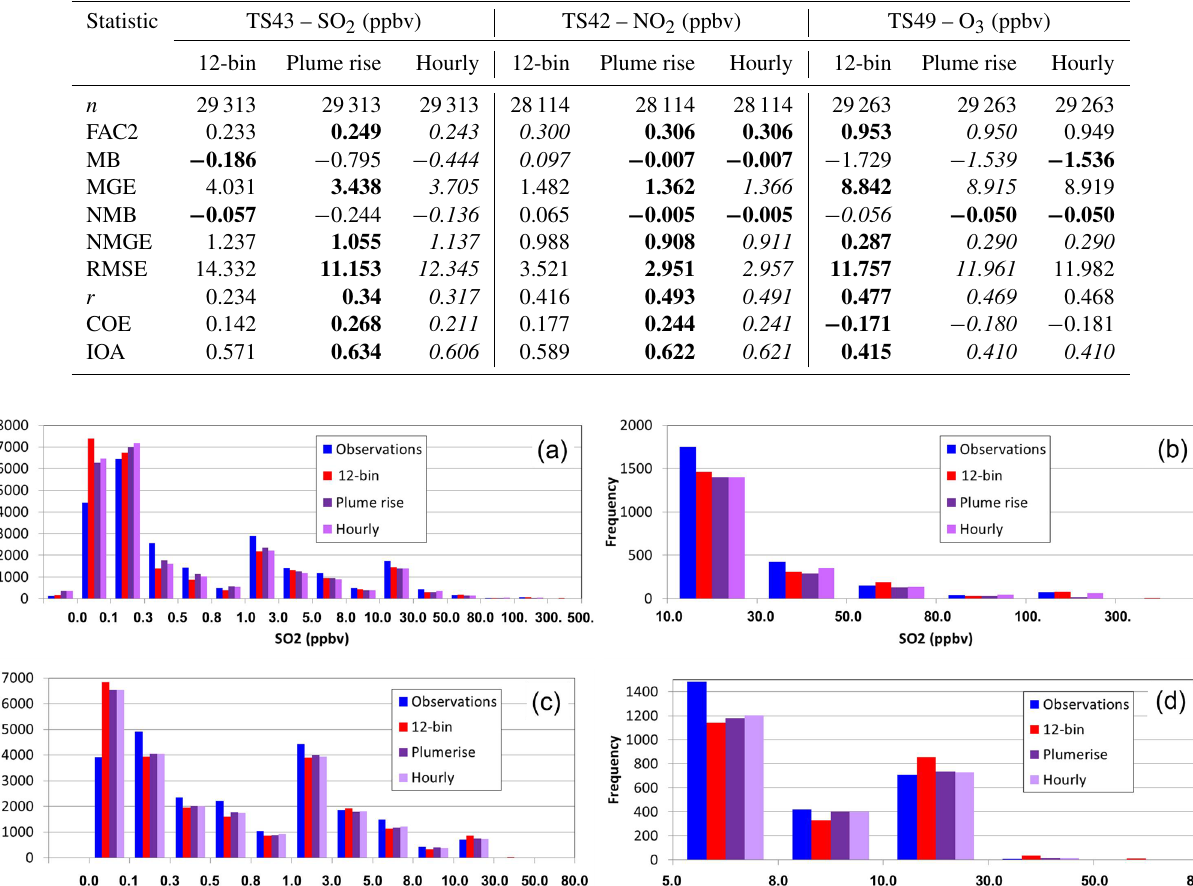
Table 6. Comparison of statistical measures of SO 2 , NO 2 , and O 3 measurements from the aircraft campaign against the 2.5km resolution GEM-MACH simulations between 13 August and 10 September 2013.